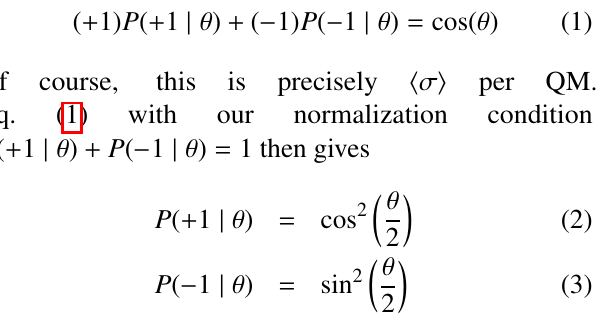
Figure 1: A Stern–Gerlach (SG) spin measurement showing the two possible outcomes, up ( + ℏ for short. As Weinberg points out, this constitutes a measurement of Planck’s constant h.